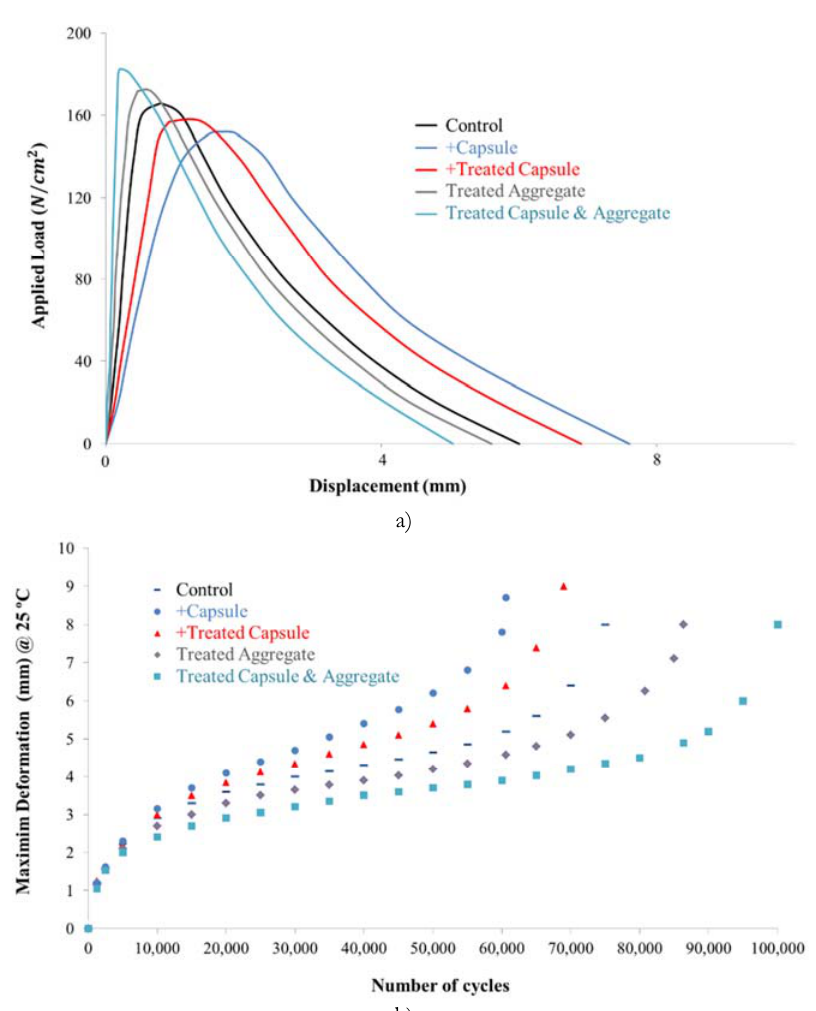
Figure 10: The results of ITS and ITF tests. a) Displacement of specimens under indirect tensile load; b) Maximum deformation of specimen during the loading Until the samples